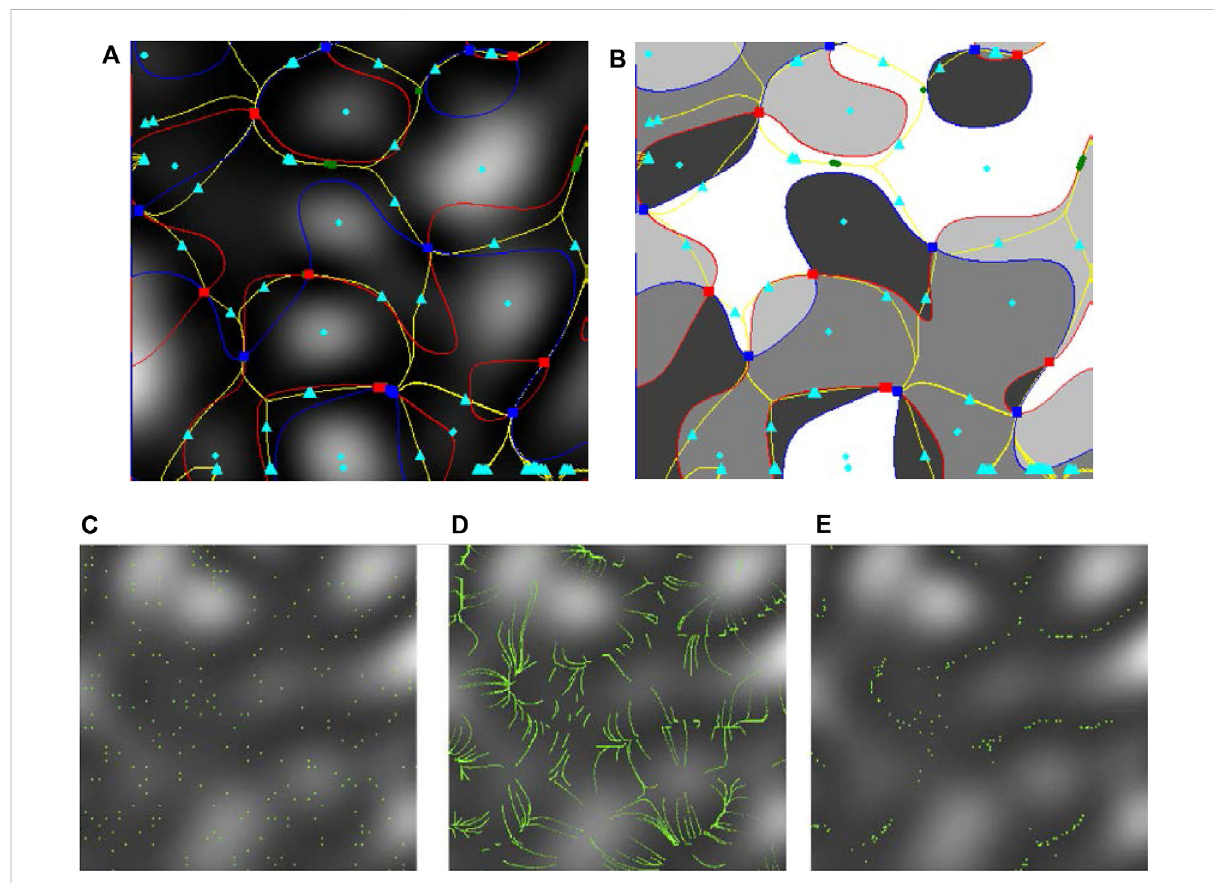
FIGURE 15 Top row: (A) Intensity and (B) phase distribution of a speckle fi eld with the marked peculiar points of the intensity and phase pro fi les [119] (explanations in text). Bottom row: Views of the luminescent nanoparticles in the tested speckle fi eld [121]: (C) At the moment of speckle fi eld switching; (D) Recorded tracks of the particles during their fi eld-induced motion; (E) The particles ’ positions after their redistribution to the low- intensity regions (observation time 5